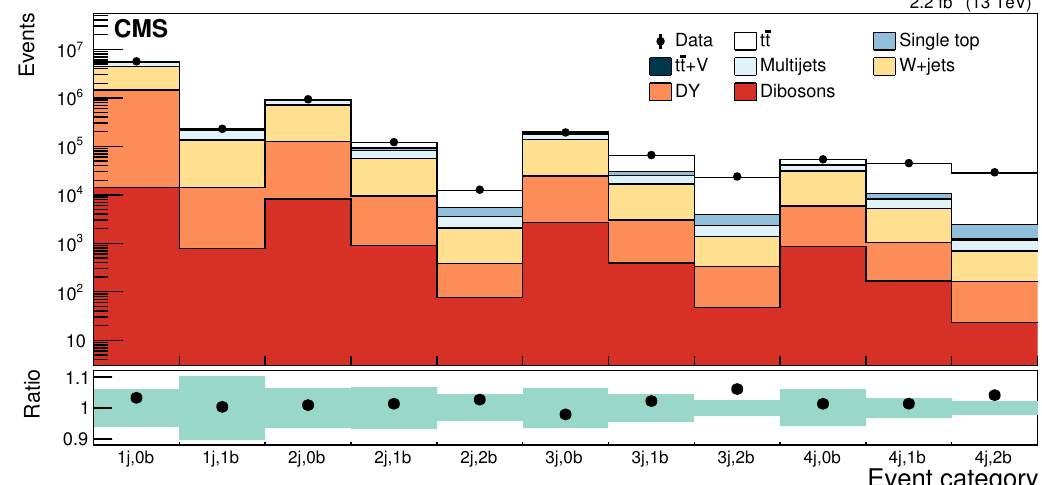
Figure 1 . Event yields from data and the expected tt signal and backgrounds for each of the 11 independent categories. Distributions are combined for the two lepton charges and (cid:13)avors. The bins represent the measured number of jets (j) and b-tagged jets (b), with the 4j and 2b categories being inclusive. The bottom panel shows the ratio between the data and the expectations. The relative uncertainty owing to the statistical uncertainty in the simulation, the uncertainty in the normalization of the multijet contribution, and the systematic uncertainty in the total integrated luminosity is represented as a shaded